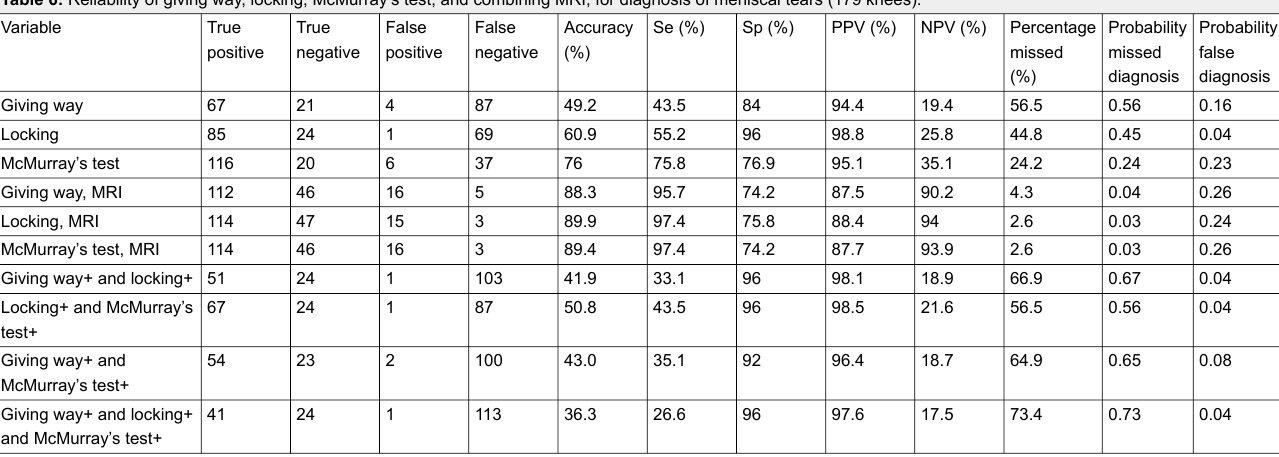
Table 6: Reliability of giving way, locking, McMurray’s test, and combining MRI, for diagnosis of meniscal tears (179 knees). Variable